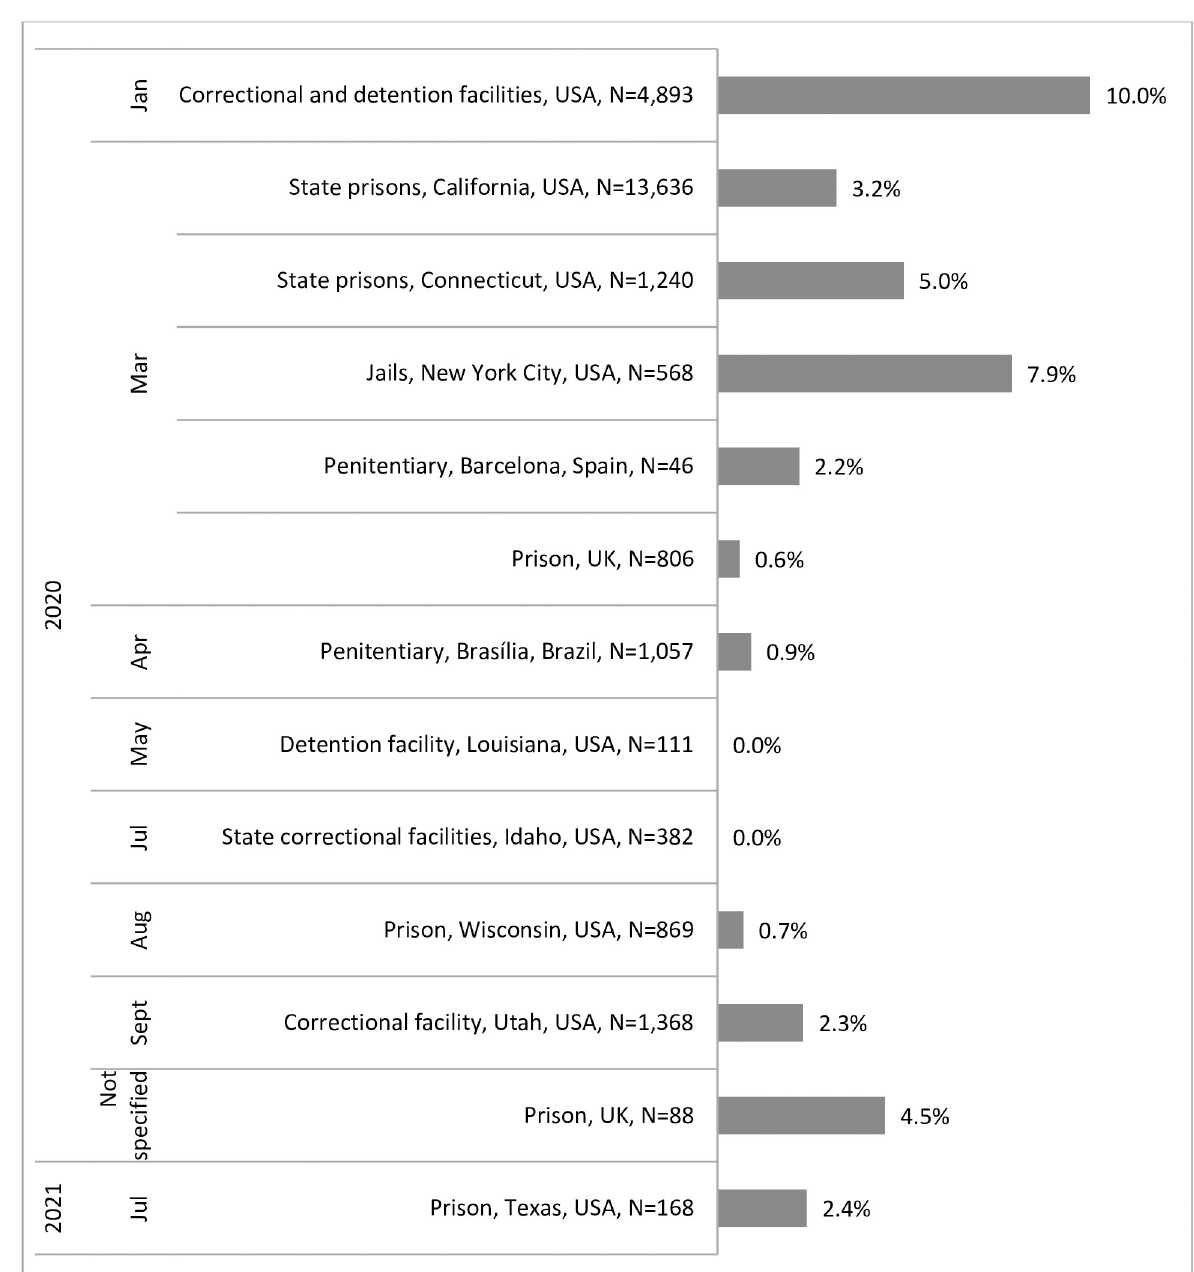
Fig 3. Percent of COVID-19 cases hospitalized for people who experience imprisonment in studies included in a systematic review on the health impacts of the COVID-19 pandemic on people who experience imprisonment, by month of start of study